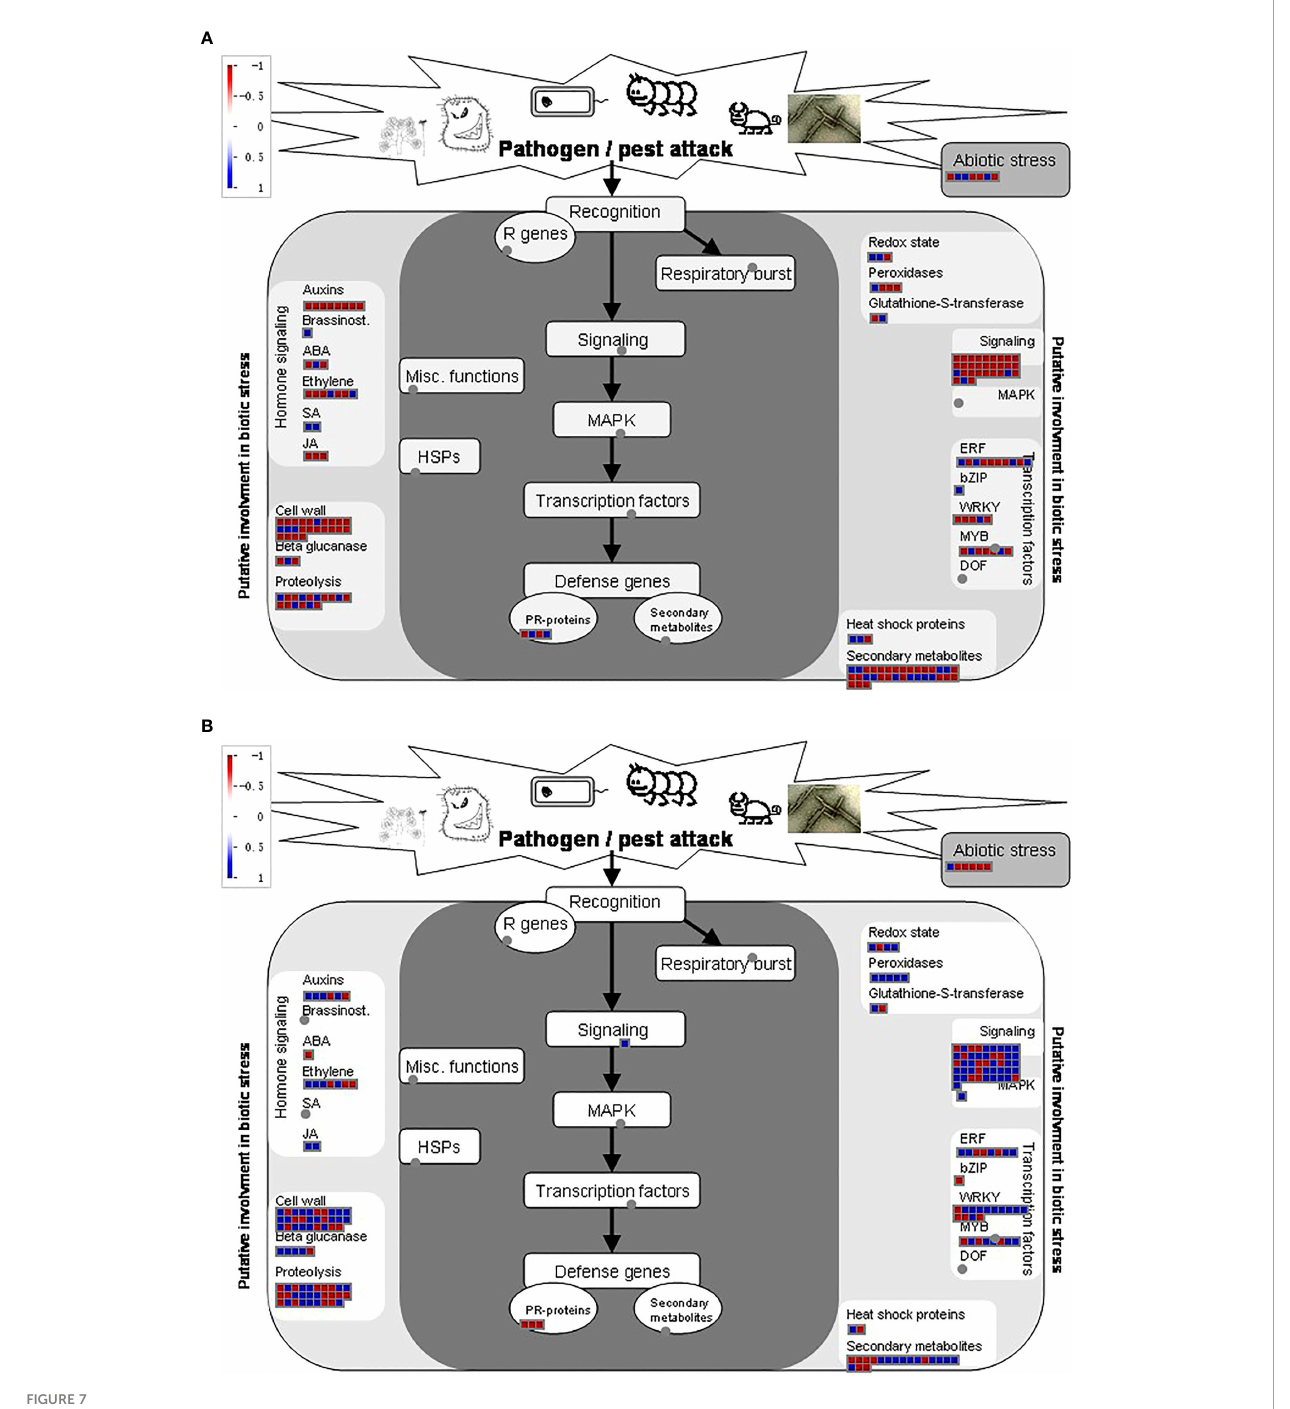
FIGURE 7 Distribution of DEGs in response to abiotic stresses among; (A) KW and (B)